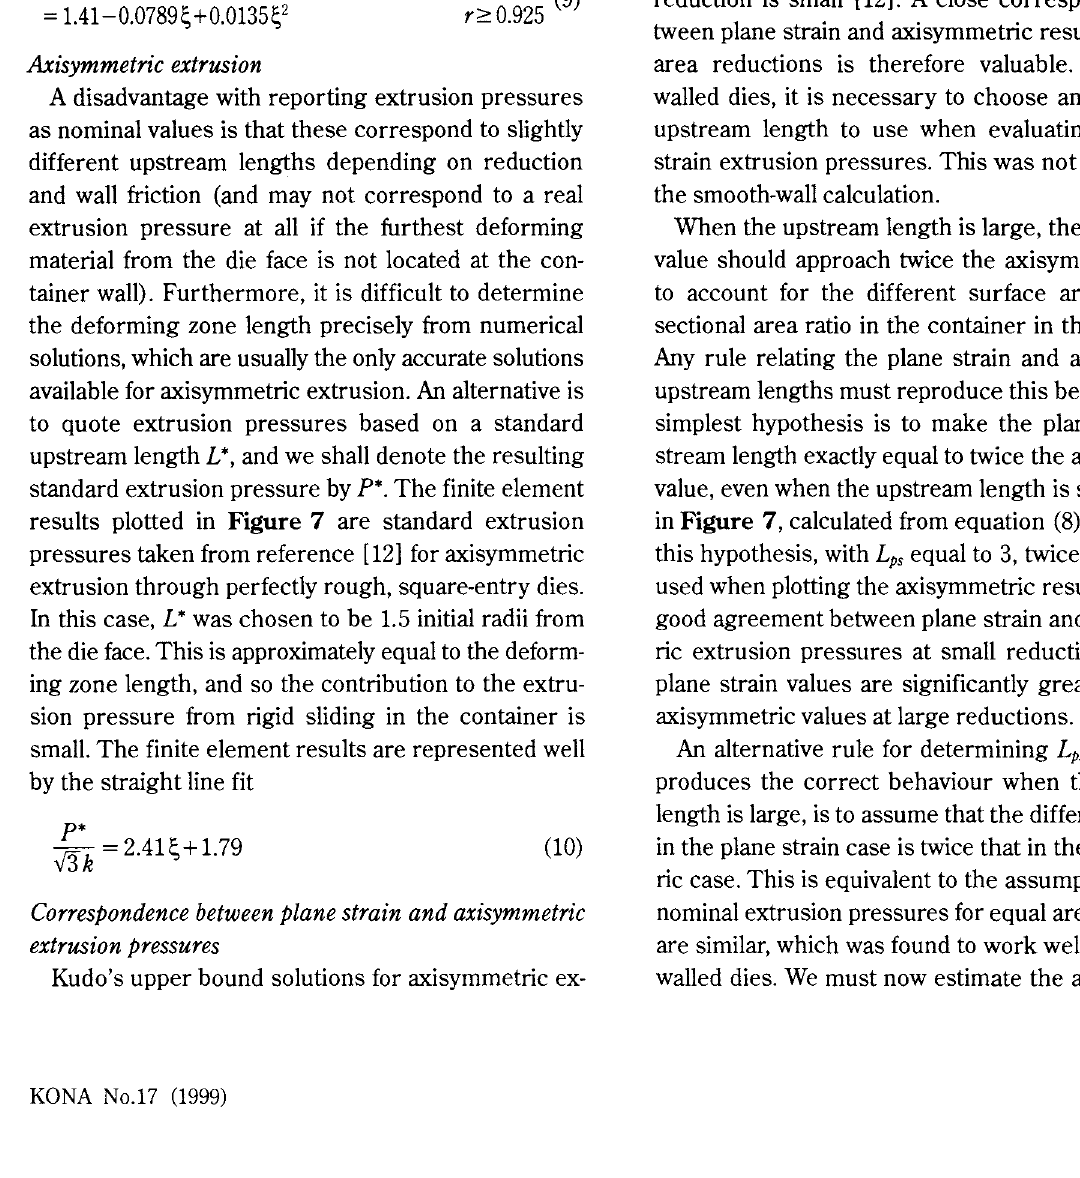
Fig. 6 Nominal extrusion pressures and deforming zone lengths for plane strain extrusion through perfectly rough, square entry dies; from slipline field solutions.